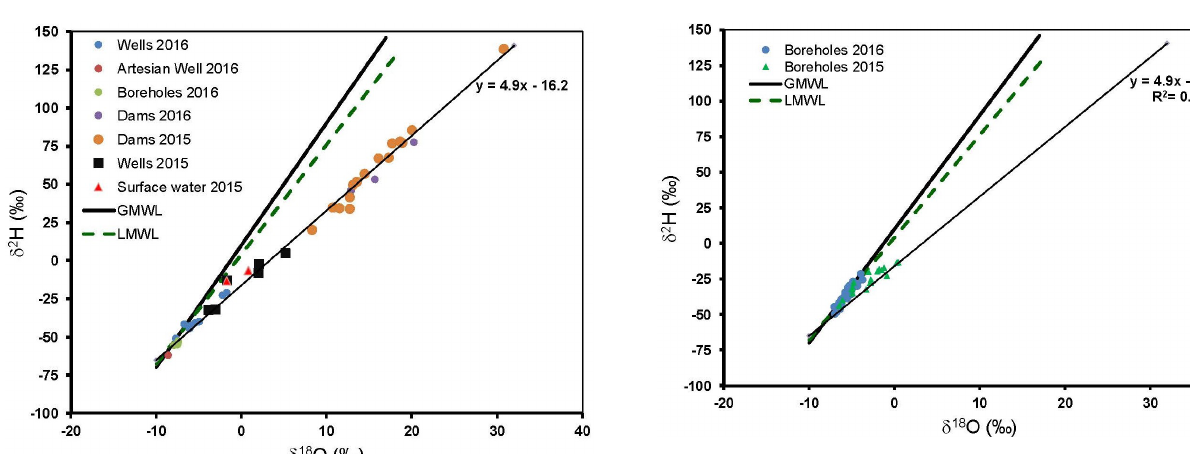
Figure 3. Plot of the stable oxygen isotopes ( δ 18 O) vs. hydrogen ( δ 2 H) for water samples from the Kuiseb Basin. GMWL is the global meteoric water line and LMWL is the local meteoric water